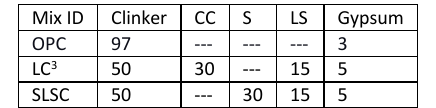
Table 2 . Mix composition of the blended cements in weight